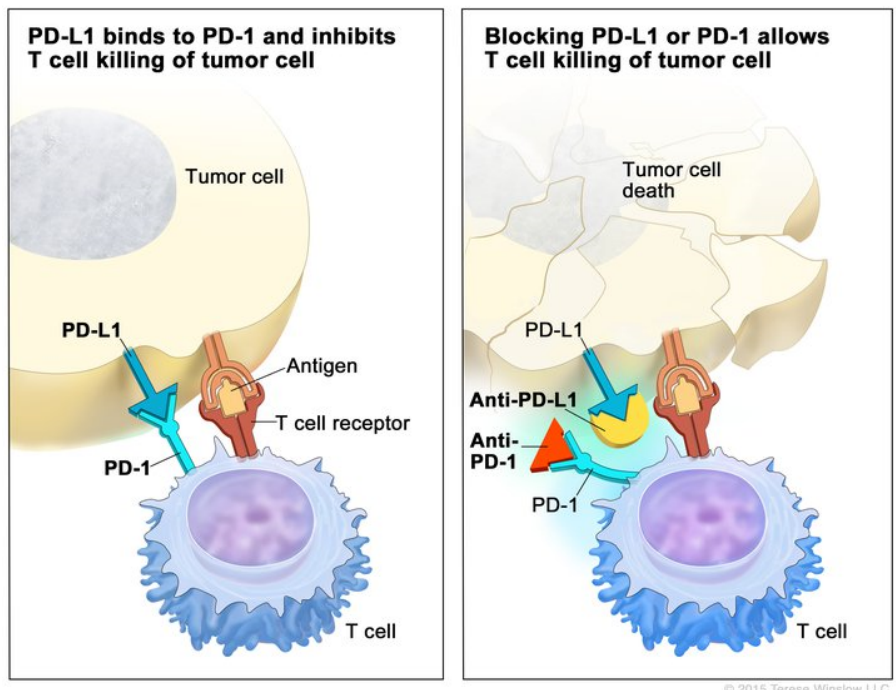
Figure 1. Mechanism of PD-1 and PD-L1 immune checkpoint inhibitors. ( Left ) The binding of PD-1 on the T cell to PD-L1 on the tumor cell inhibits effector T cell function, despite binding of the T cell receptor to an antigen. ( Right ) Blockade of PD-1 or PD-L1 with monoclonal antibodies prevents PD-1 binding with PD-L1 and promotes effector T cell function, leading to apoptosis of the tumor cell. Used with permission from Terrese Winslow LLC.